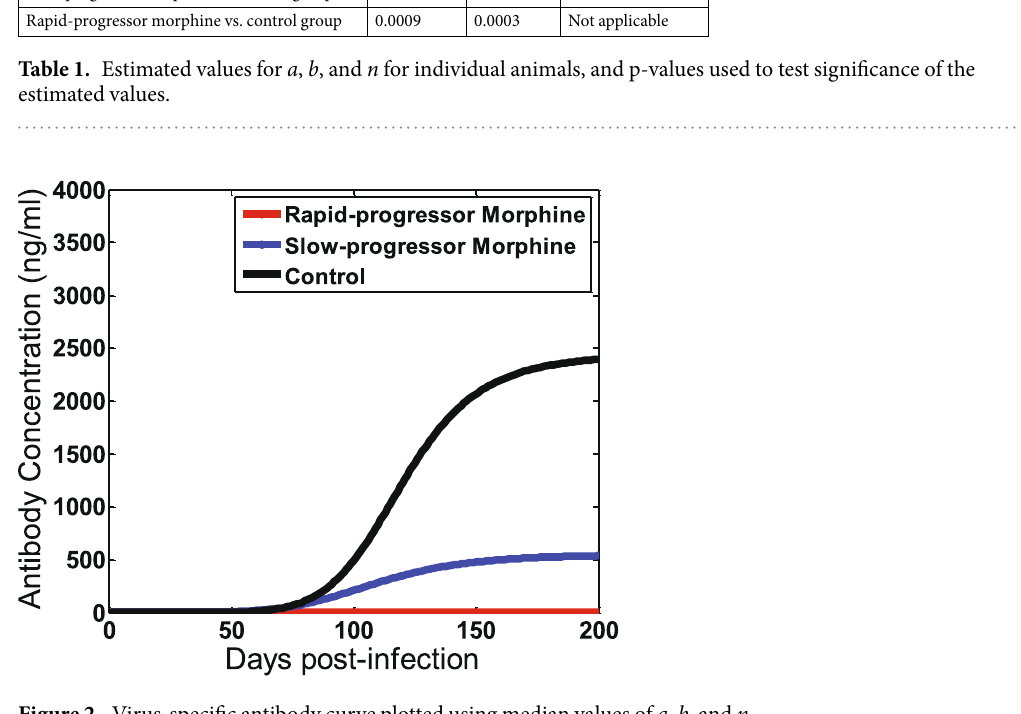
Figure 2. Virus-specific antibody curve plotted using median values of a , b , and n